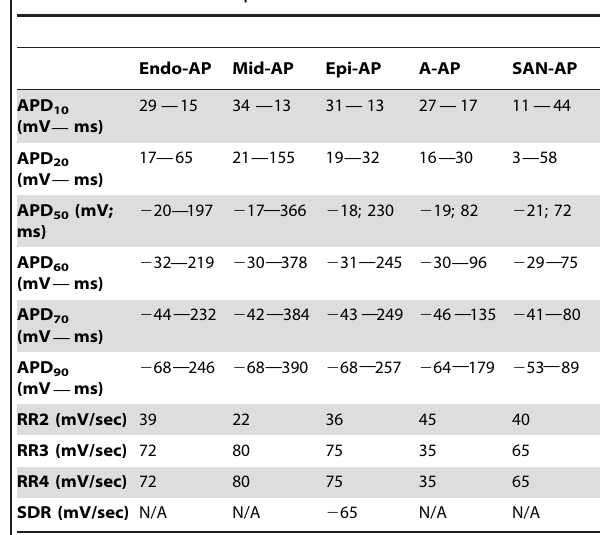
Table 1. Characteristics of Action Potentials Recorded From Various Regions of Canine Heart and Used as Command Waveforms for